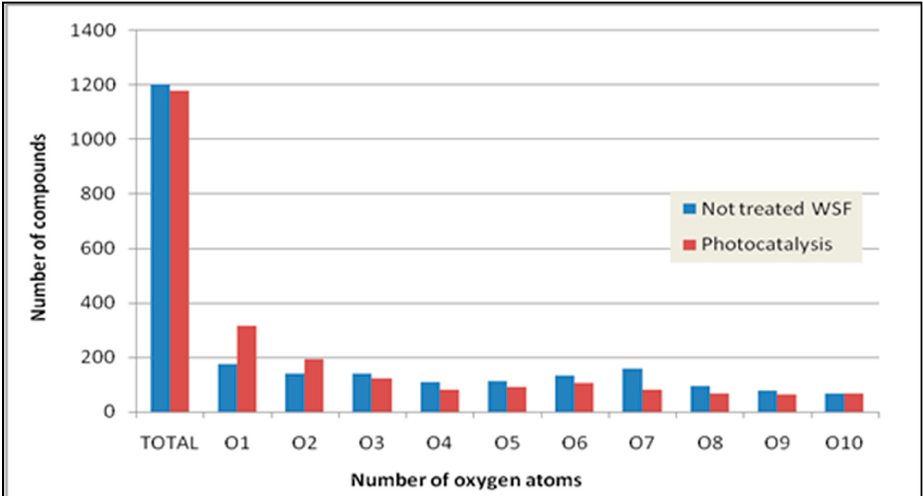
Figure 6. FT-ICR MS analysis of natural and 1-h photocatalysed WSF of crude oil as a function of the number of oxygen atoms.